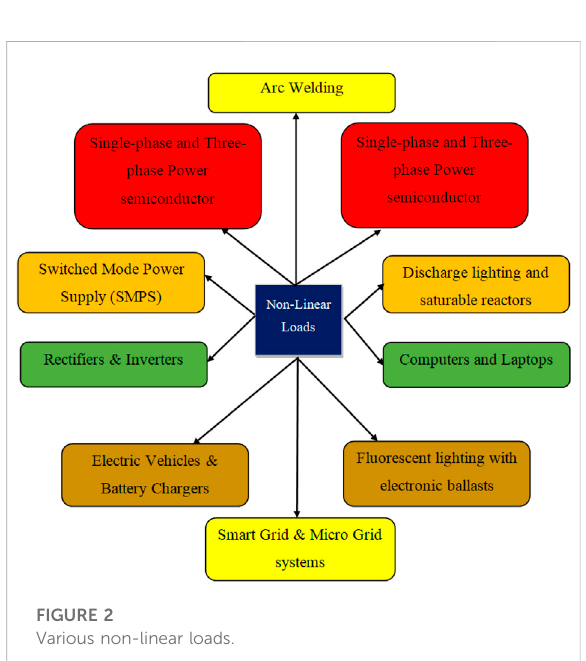
FIGURE 2 Various non-linear